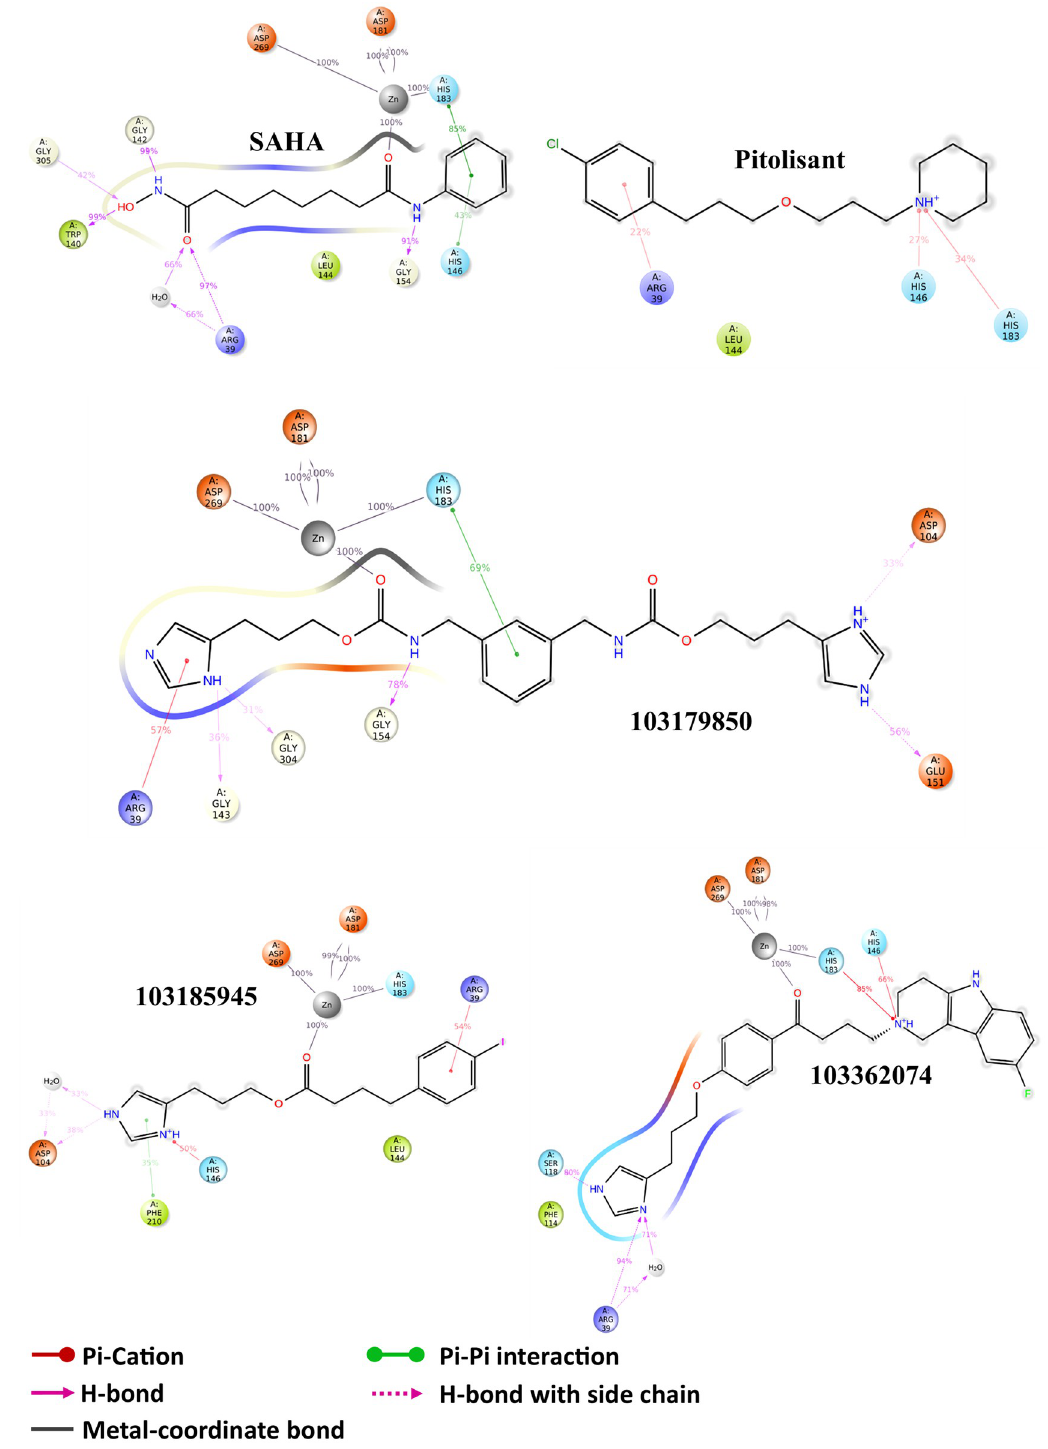
Fig 9. 2D interaction diagram of HDAC2 with respective ligands showing the interaction profile of 100ns MD simulation.